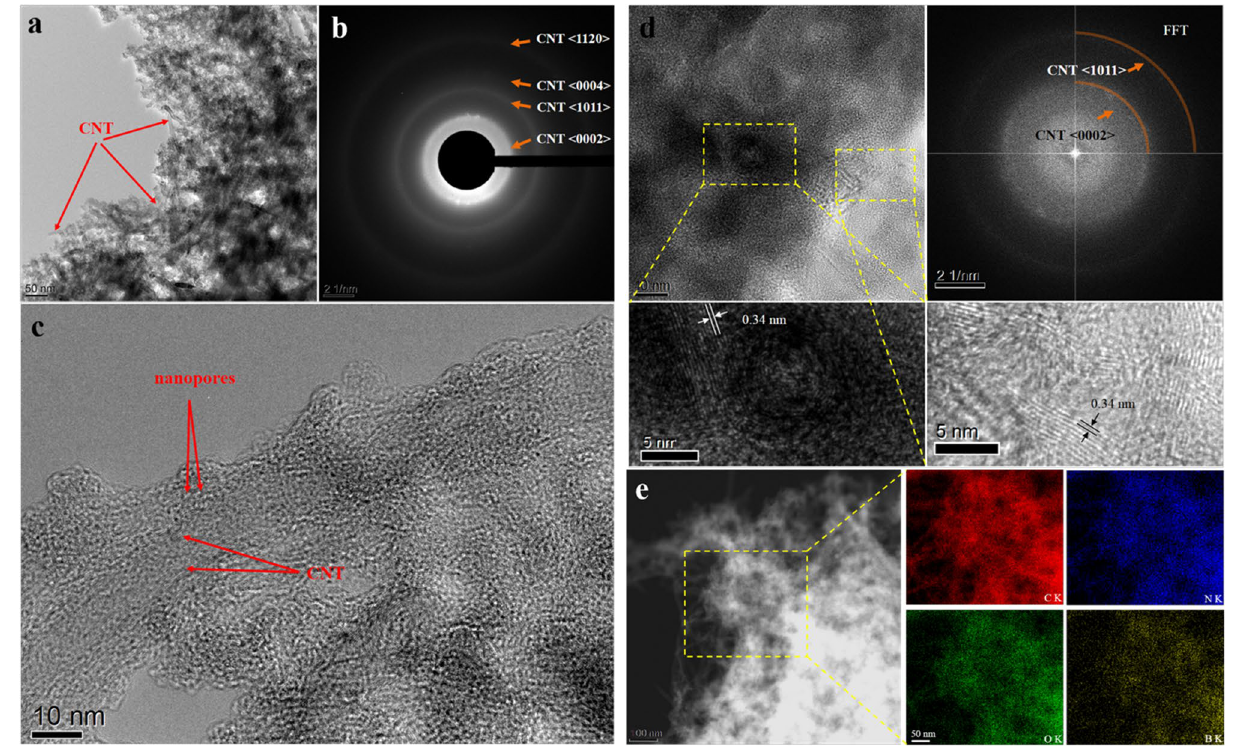
Figure 3. ( a , b ) low magnification TEM image and the corresponding SAED pattern of NBC@MWCNTs; ( c ) High resolution TEM image of a single CNT wrapped by nanoporous materials in NBC@MWCNTs; ( d ) High resolution TEM image and FFT pattern of the typical structure in NBC@MWCNTs; ( e ) HAADF image and corresponding elemental distribution mappings of N, B, O, and C in the